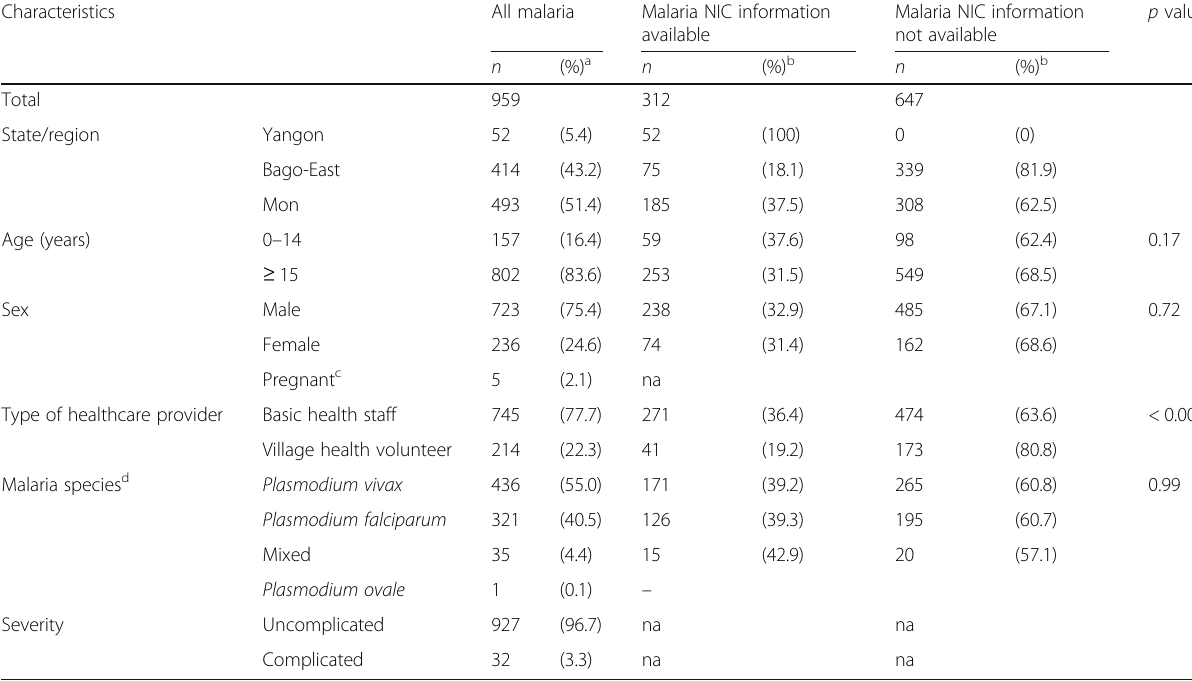
Table 2 Socio-demographic, clinical characteristics of patients with malaria in three low-endemic settings of Myanmar, 2016 Characteristics All malaria Malaria NIC information